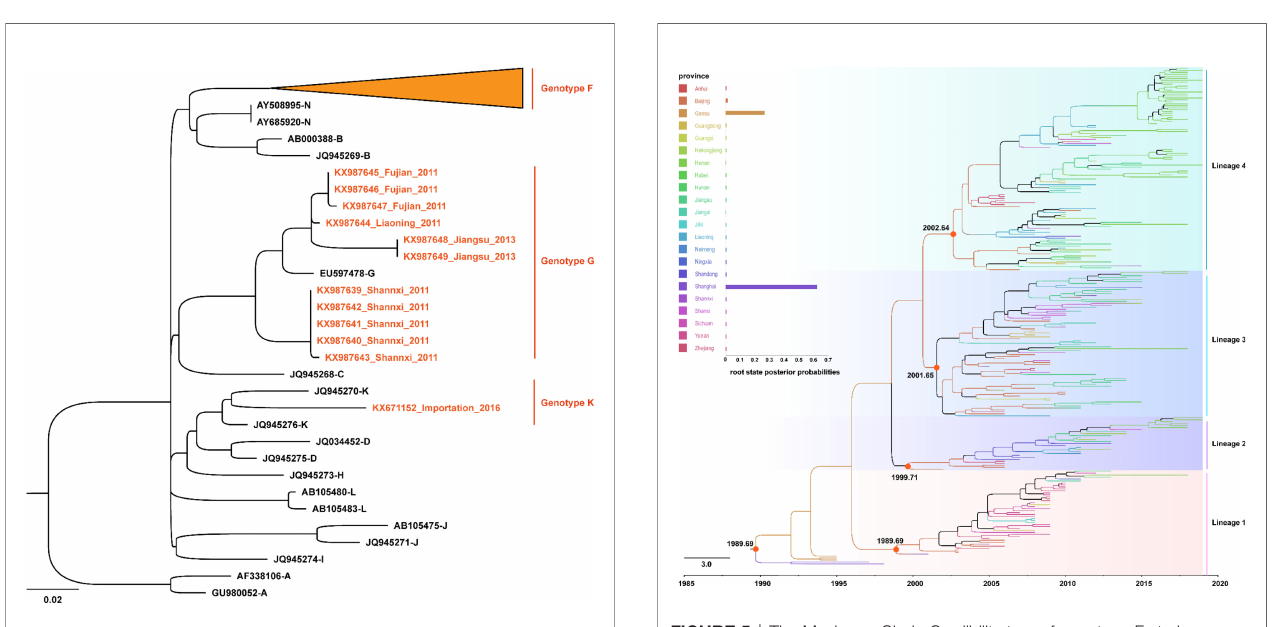
FIGURE 4 | Phylogenetic analysis of mumps strains circulated in China based on 313 nucleotides of the SH gene, with reference strains of 12 genotypes (A, B, C, D, F, G, H, I, J, K, L, and N). The nucleotide substitution model used in this phylogenetic tree was K3Pu+F+G4, and the bootstrap value was set as 2000. The orange font and the sequences marked by the orange ▴ symbols are the strains circulated in China.